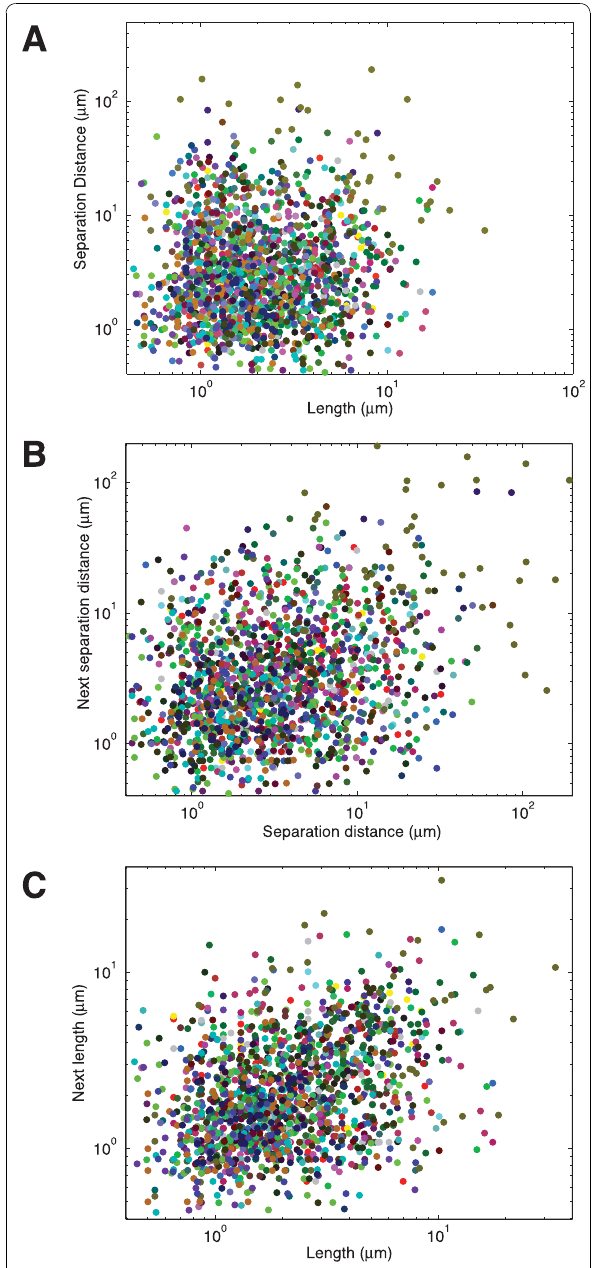
Figure 4 Filopodia length and distance separation are independent . (A) Scatter plot of filopodia lengths against the neighboring distances shows no correlation. Identically coloured data points represent measurements from the same cell. (B) Scatter plot of the distances between filopodia versus the distances between the next filopodia in a clockwise direction around the edge of the cell. (C) Scatter plot of the lengths of filopodia versus the lengths of the next filopodia in a clockwise direction around the edge of the